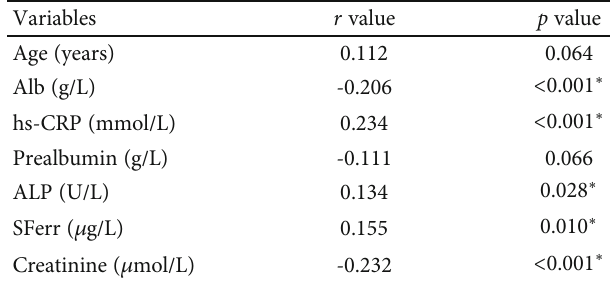
Table 2: Correlation analysis for variables and ERI in MHD